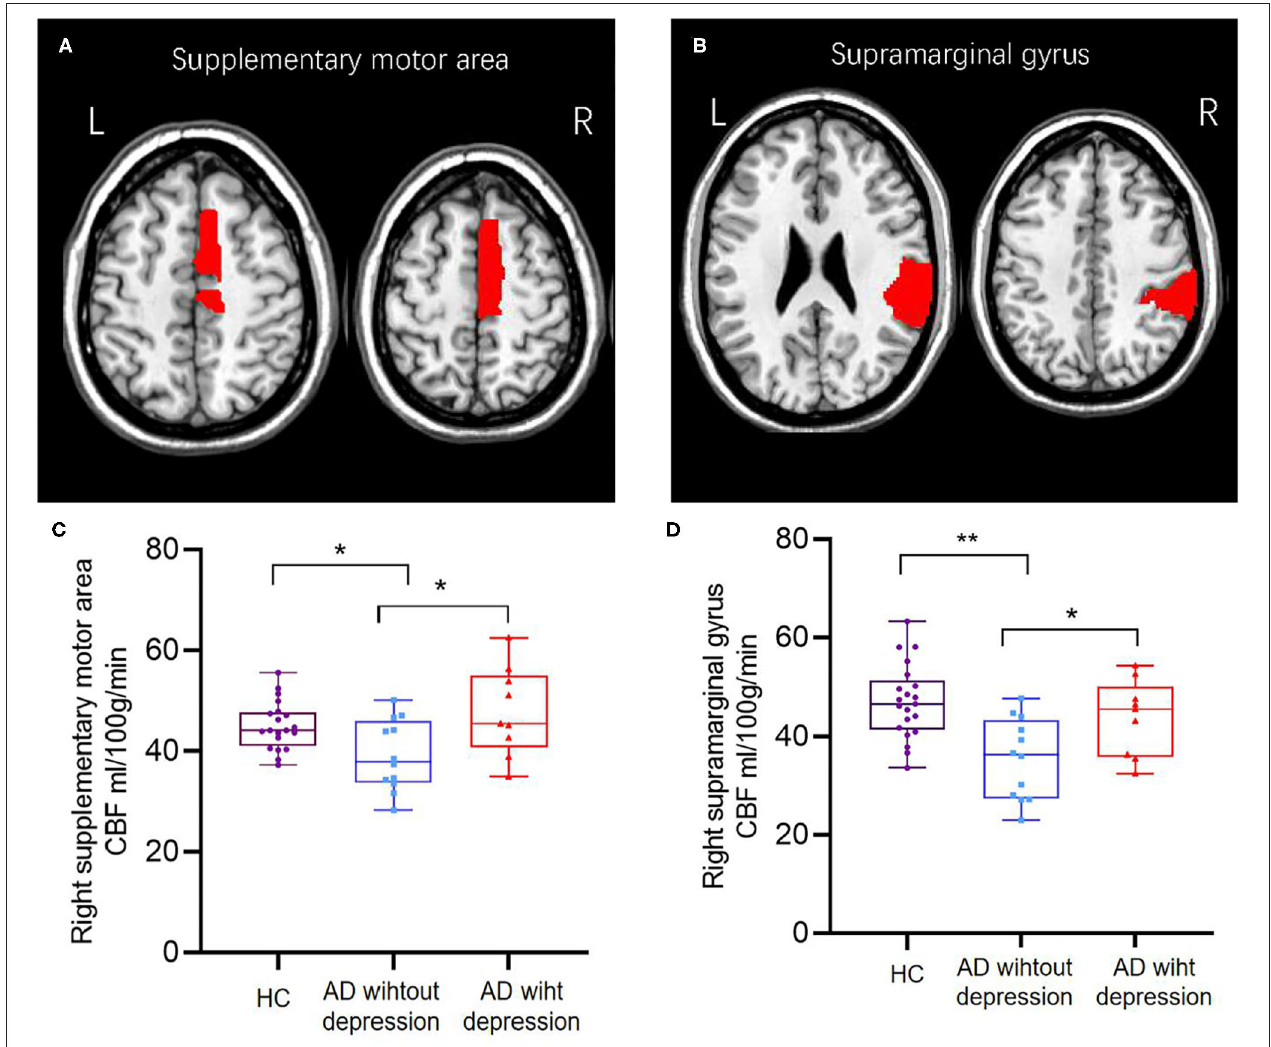
FIGURE 1 | The brain region of the right supplementary motor area (A,C) and right supramarginal gyrus (B,D) showed different CBFs between healthy controls and AD patients with or without depression; AD patients with depression had higher cerebral blood flow than AD patients without depression. * p < 0.05; ** p <